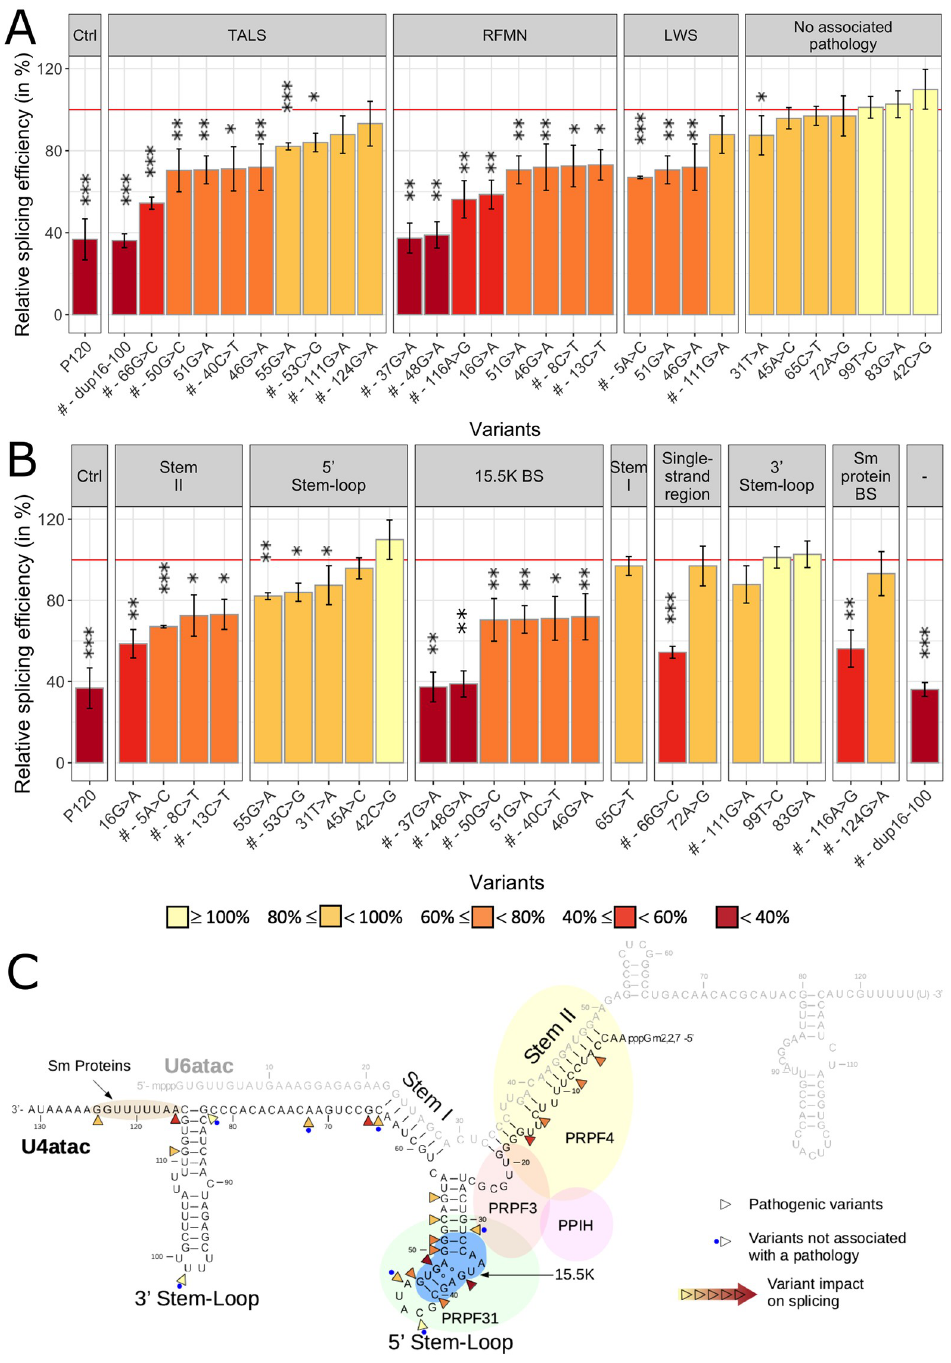
Fig 5. Results of the cellular assay obtained with the 24 tested variants. Variants are organised by A . associated pathologies (the same variant may appear several times when found in more than one syndrome) or B . mutated region of the U4atac/U6atac bi-molecule. Variants are further organised by relative splicing efficiency. The strength of the effect on splicing is colour-coded using a gradient from yellow showing the lowest effect (high splicing efficiency) to dark red showing the highest effect (low splicing efficiency). C . Representation of the magnitude of the impact of variants on splicing on the U4atac/U6atac bi-molecule using the same colour code. For clarity, variants’ names were simplified; those identified in the compound heterozygous state only are shown with a # (all the others have been identified in both homozygous and compound heterozygous states). Error-bars represent standard error of the mean (SEM) of at least three independent experiments. Statistically significant differences in splicing efficiency are